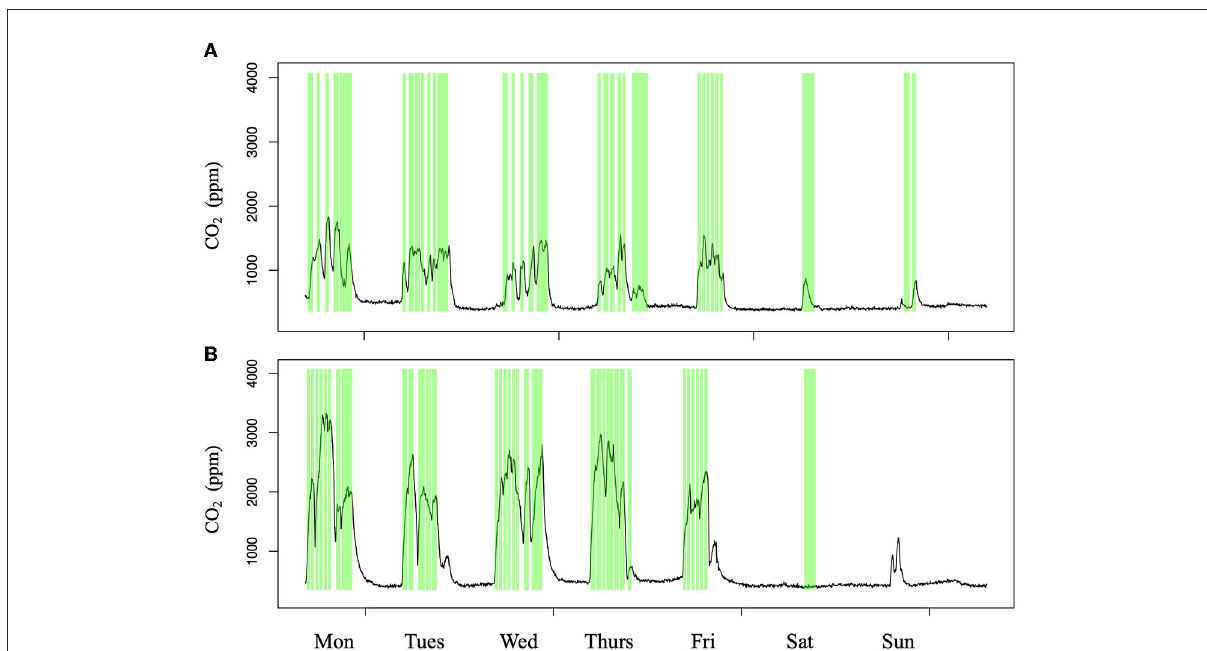
FIGURE3 Two examples of classroom CO 2 measurements over a week compared with class times, out of 20 classrooms monitored. CO 2 sensors (Onset HOBO Bluetooth Low Energy Carbon Dioxide—Temp—RH Data Logger, #MX1102) were installed in classrooms for 1 week. Occupation data was collected for these classrooms from the 25Live scheduling system used by BU. Class times (green boxes) were plotted against CO 2 concentrations (black lines) over time to compare CO 2 spikes with classroom usage. Spikes occurred primarily during class time in classrooms (A) CAS 201 and (B) CAS